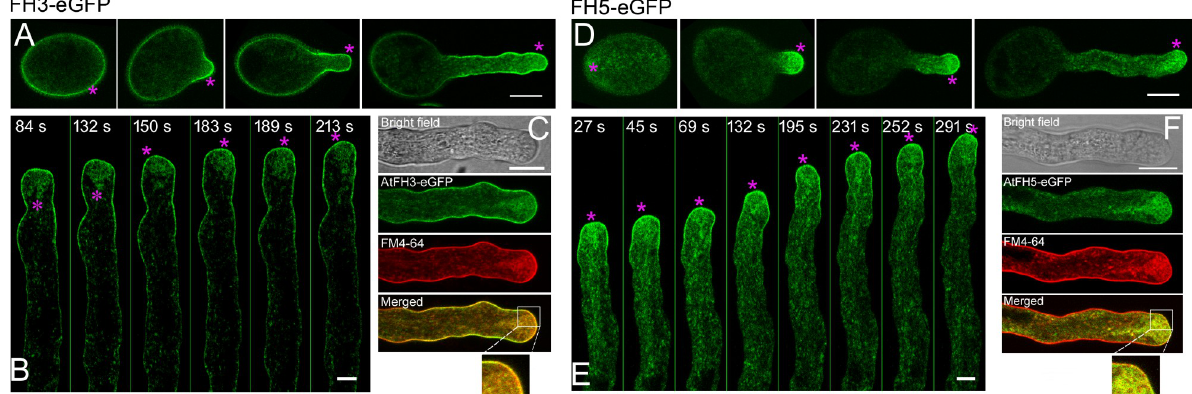
Fig 4. Intracellular localization of AtFH3 and AtFH5 in pollen tubes. ( A ) Distribution of AtFH3-eGFP in ungerminated and germinated pollen derived from AtFH3pro : FH3-eGFP;fh3-1 plants. Medial optical sections are presented. The magenta asterisks indicate the localization of AtFH3-eGFP on the PM. Bar = 10 μ m. ( B ) Time-lapse images of AtFH3-eGFP in the growing pollen tube. The magenta asterisks indicate the localiztion of AtFH3-eGFP on the PM and vesicles. Bar = 5 μ m. ( C ) Co-localization of AtFH3-GFP with FM4-64-stained plasma membrane and endocytic vesicles. Bar = 10 μ m. ( D ) Distribution of AtFH5-eGFP in ungerminated and germinated pollen derived from AtFH5pro : FH5-eGFP;fh5-2 plants. Medial optical sections are presented. The magenta asterisks indicate the localization of AtFH5-eGFP on the PM. Bar = 10 μ m. ( E ) Time-lapse images of AtFH5-eGFP in the growing pollen tube. The magenta asterisks indicate the localization of AtFH5-eGFP on the PM and vesicles. Bar = 5 μ m. ( F ) Co- localization of AtFH5-GFP with FM4-64-stained plasma membrane and endocytic vesicles. Bar = 10 μ m.